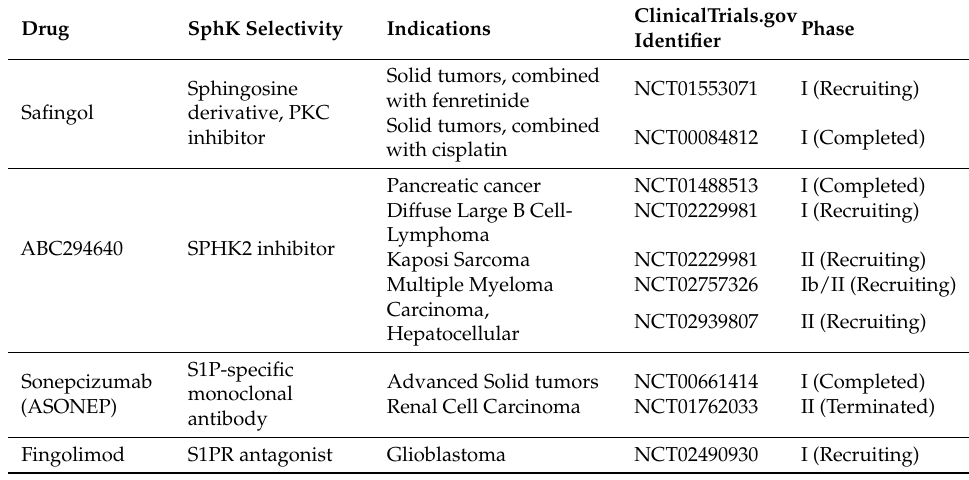
Table 4. SphK/S1P/S1PR drugs in clinical trials related to cancer treatment (Adapted from [12]). Drug SphK